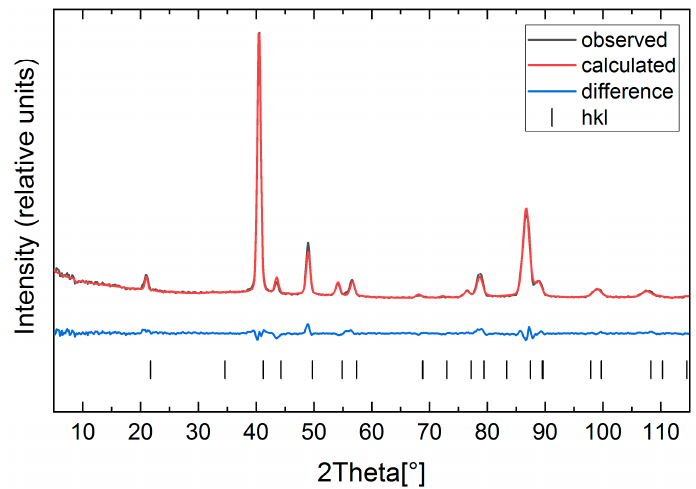
Figure 4. Magnetic refinement of the neutron powder diffractogram of Mn 1.8 Co 0.2 Sb at 350 K (Shubnikov group : P 4/ nm’m’ ).